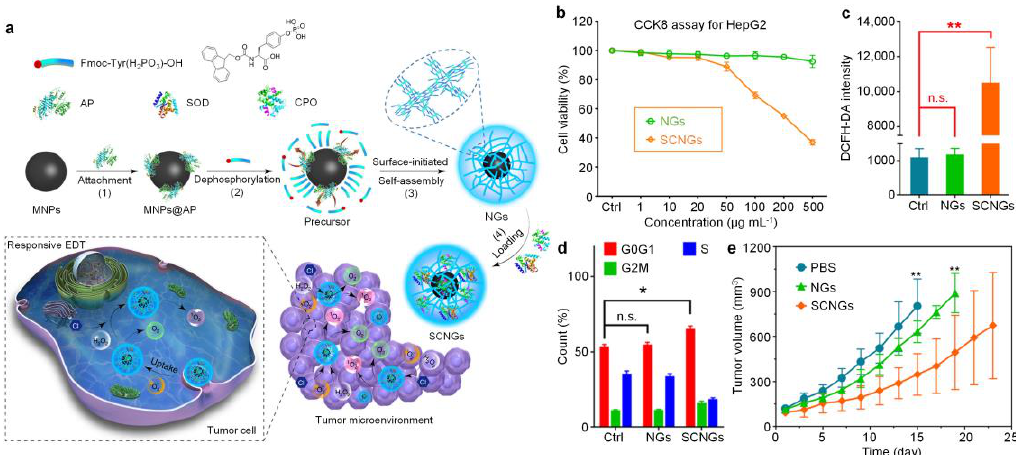
Figure 6. ( a ) Schematic illustration of SCNGs (superoxide dismutase (SOD) and chloroperoxidase (CPO) loaded onto nanogels (NGs)) preparation and mechanism of responsive enzyme dynamic therapy (EDT). ( b ) Cytotoxicity of NGs and SCNGs to HepG2 cells after 24 h incubation determined by cell counting kit-8 (CCK8) assay. ( c ) Flow cytometry analysis of fluorescence of reactive oxygen species (ROS) detector in HepG2 cells under different treatments. ( d ) Flow cytometry analysis of effects of SCNGs on cell cycles. HepG2 cells were treated by PI staining. The control, NGs and SCNGs groups represent HepG2 cells incubated with phosphate-buffered saline (PBS), NGs and SCNGs for 24 h, respectively. ( e ) Tumor volume change of hepatocellular carcinoma patient-derived xenograft (HCC PDX) mouse model under different treatments. The error bars represent standard deviation of six different measurements ( n = 6). * p < 0.05; ** p < 0.01; n.s. represents no significant differences. Adapted from [53]. Copyright© 2019 Springer Nature.